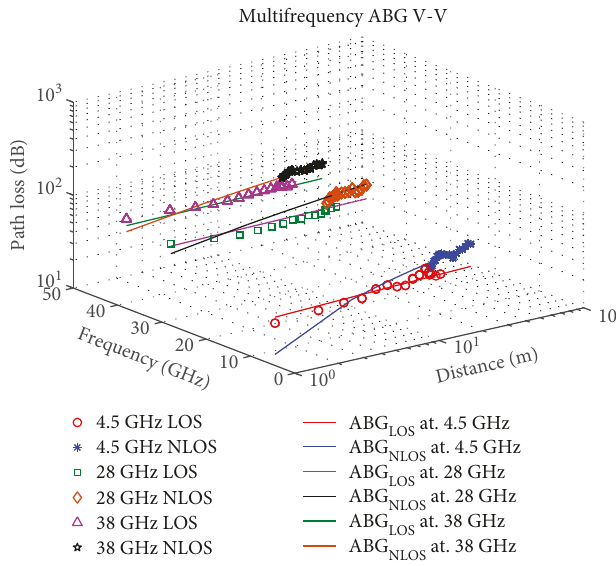
Figure 8: ABG model for directional V-V for LOS and NLOS at 4.5, 28, and 38GHz.